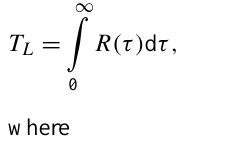
Fig. 4b. Temporal evolution of four times the kinetic energy (4E) (red curve) and of the mean square relative velocity < δu 2 > (green curve) of the particle pairs separated initially by D 0 = 11 . 1km. In the inset we show the temporal evolution of the Lagrangian corre- lation function at 44m